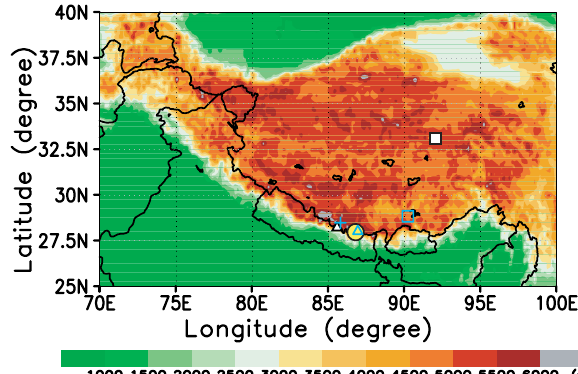
Fig. 1. Location map of research sites focused in this study. The large circle in yellow denotes NCO-P site. The triangle and square in white colour denote the locations of Yala Glacier, and Dongkemadi Glacier, respectively. The cross, triangle, and square in sky blue denote the locations of Kangwure Glacier, East Rong- buk Glacier, and Qiangyong Glacier, respectively, where BC con- centrations in snow were measured by Xu et al. (2006) and Ming et al. (2008, 2009). The Merged IBCAO/ETOPO5 Global Topo- graphic Data Product by Holland (2000) was used for topography